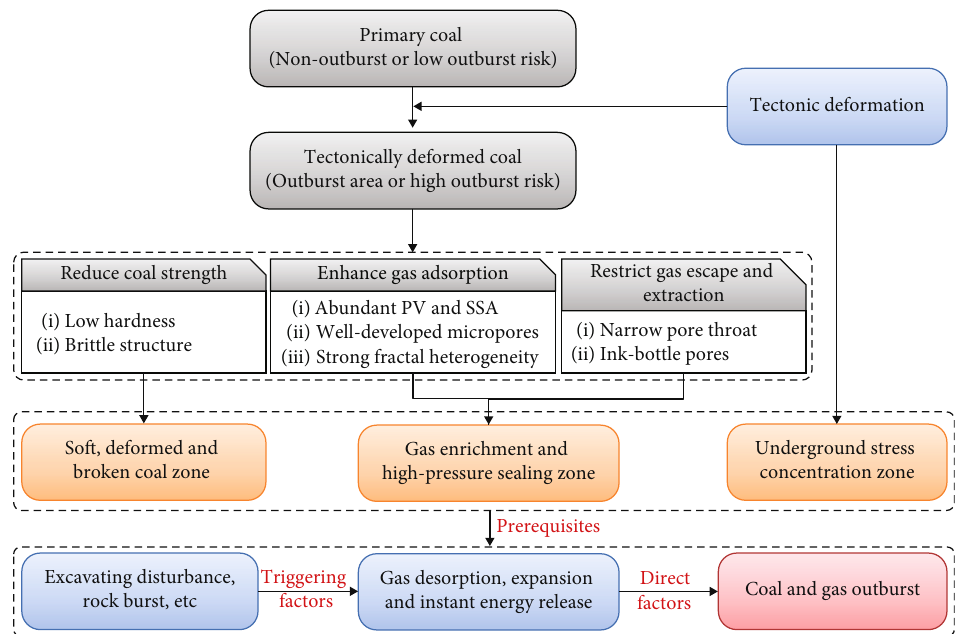
Figure 17: The combined e ff ect of tectonic deformation, pore structure, and gas adsorptivity on coalbed gas occurrence and